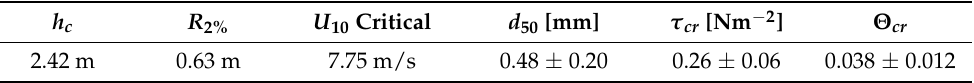
Table 1. Parameters determined from the acoustic and meteorological time